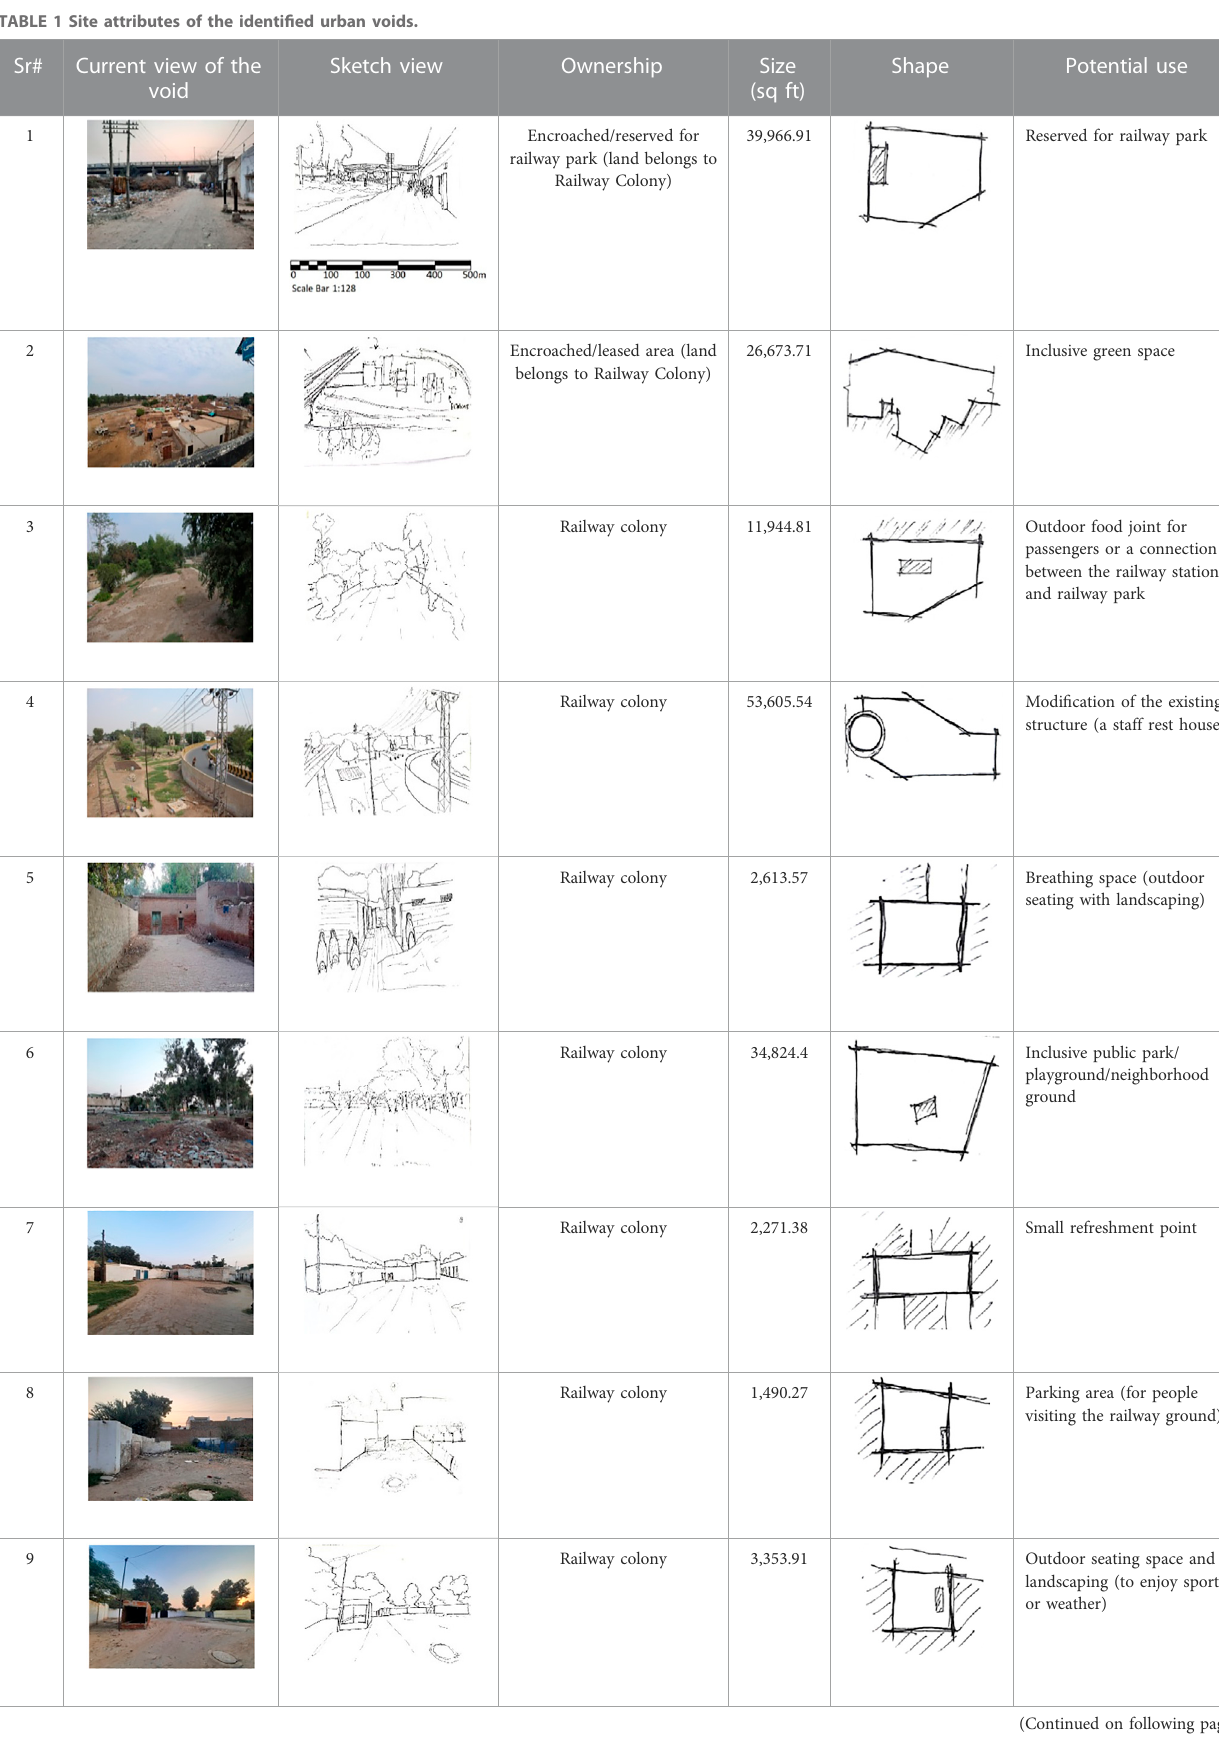
TABLE 1 Site attributes of the identi fi ed urban